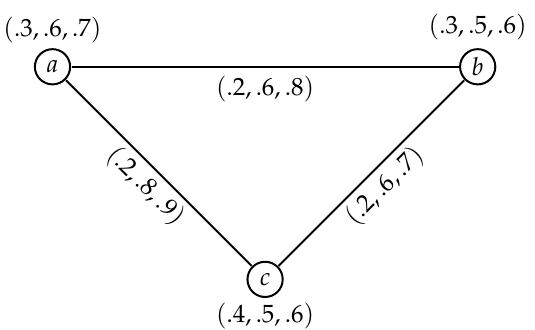
Figure 1. A neutrosophic graph G .